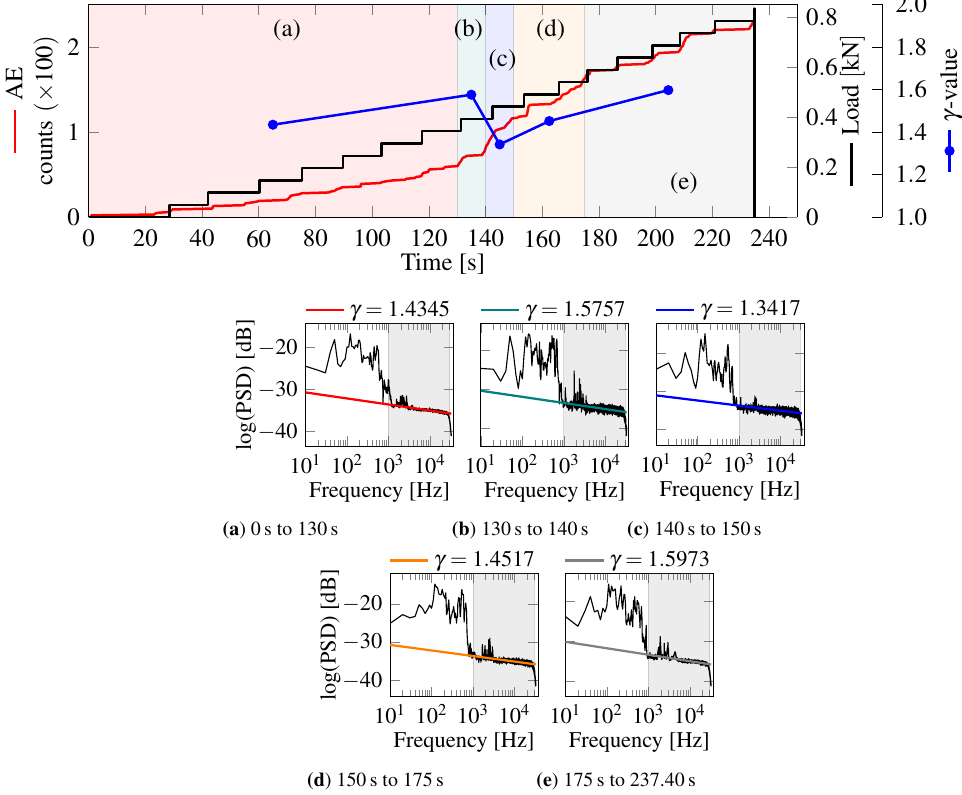
Figure 13. Evolution of γ throughout the AE